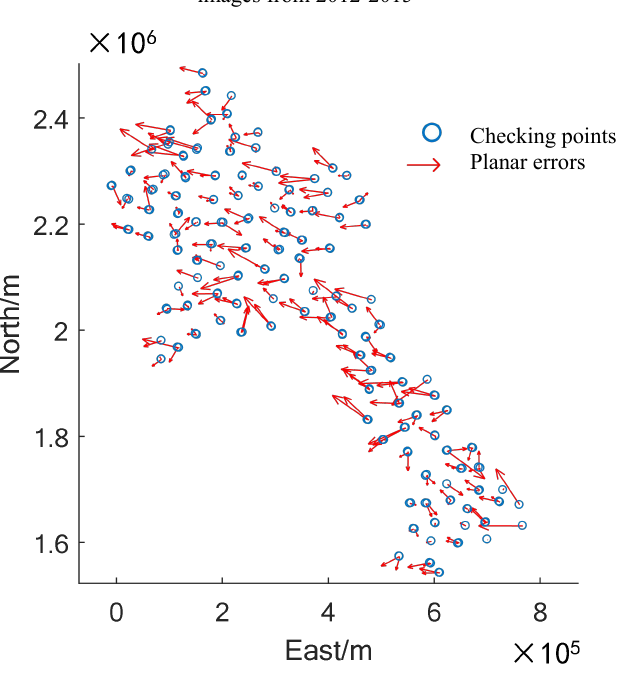
Figure 7. The DOM mosaic generated utilizing ZY-3 satellites images from 2012-2015